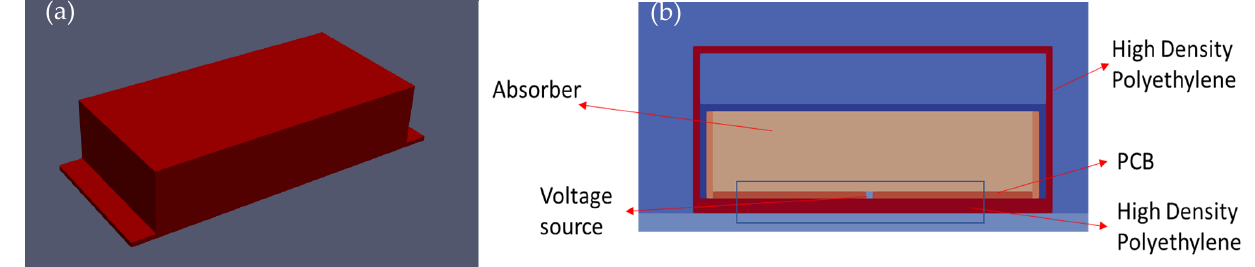
9 of 14 Figure 6. Simulation setup (from ( a – c )) for variable thicknesses (4–8 mm) considered for printed circuit board and high-density polyethylene plate below the sensors, and ( d ) parametric study of various thicknesses with increasing travel times and variable energies. The parameter studies conducted in this paper demonstrate that a simple source and transmi tt er cannot accurately represent a GPR signal response, and instead, the structure of the antenna must be taken into consideration. In this study, the internal components of the antenna module were considered from a cross-sectional perspective [16], with the an- tenna model con fi ned between the plastic HDPE plates, as shown in Figure 7b. Absorbers and a perfect electric conductor were also utilized. These components were incorporated into the antenna model for the 1600 MHz frequency, along with the parameter studies. The resulting wave response closely resembled the experimental response that was ob- served between the medium and metal re fl ections. The thicknesses, dielectric constants, and conductivities of these internal components were determined through several simu- lations, and their fi nal values for the antenna design setup are noted in Table 2. Table 2. Parameter values of the antenna model obtained after several simulations. Material